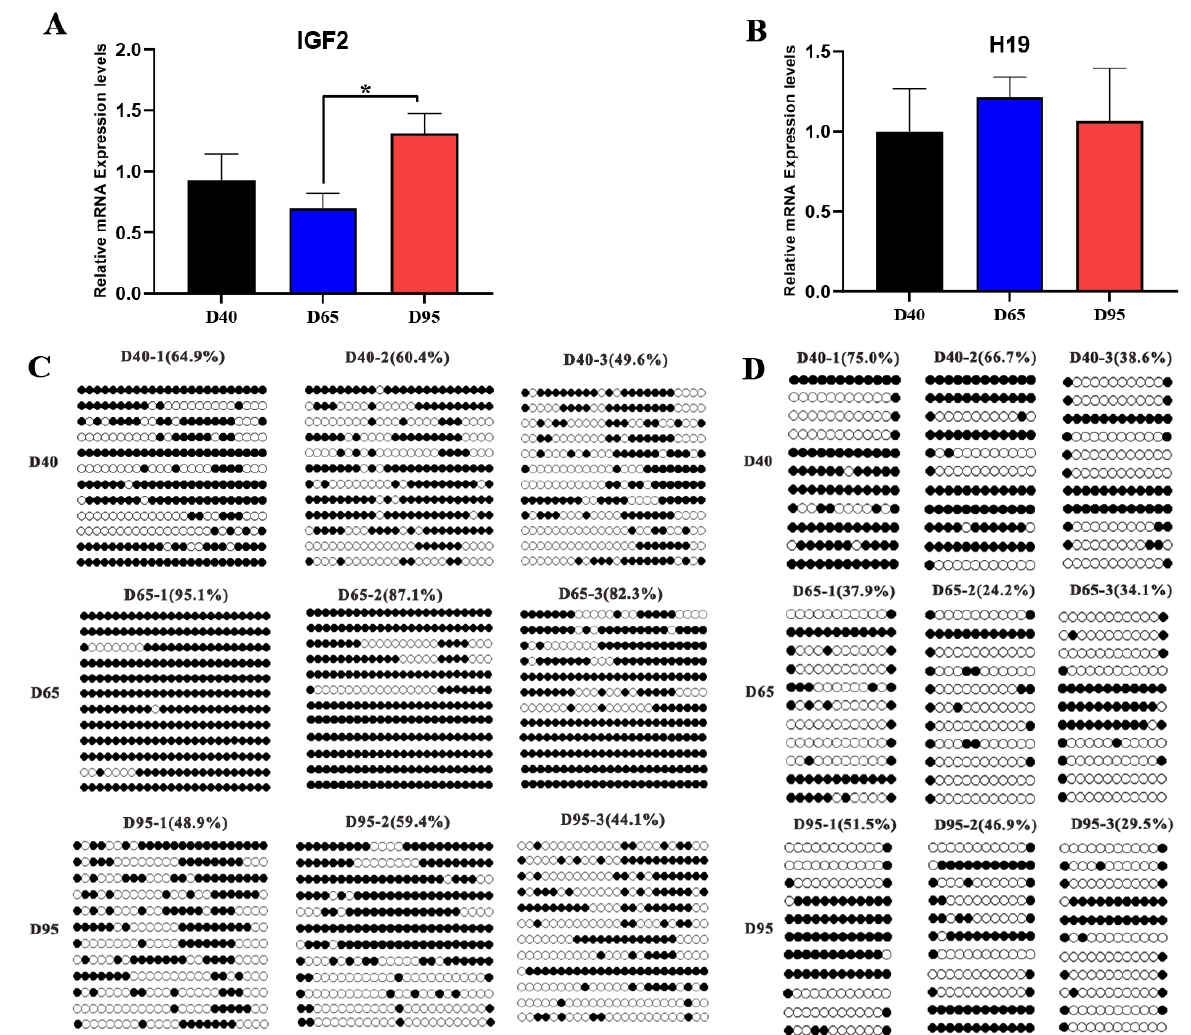
Figure 5. The expression levels and methylation levels of IGF2 and H19 in pig placentae across different gestation periods. The relative mRNA expression levels of IGF2 ( A ) and H19 ( B ) in pig placentae across different gestation periods. Methylation level of IGF2 DMR2 ( C ) and H19 CTCF3 ( D ) in pig placentae on D40, D65, and D95 of gestation. Values labeled with an asterisk (*) mean they are significantly different ( p < 0.05) within the same gene group. Black and white circles represent methylated and unmethylated CpGs,